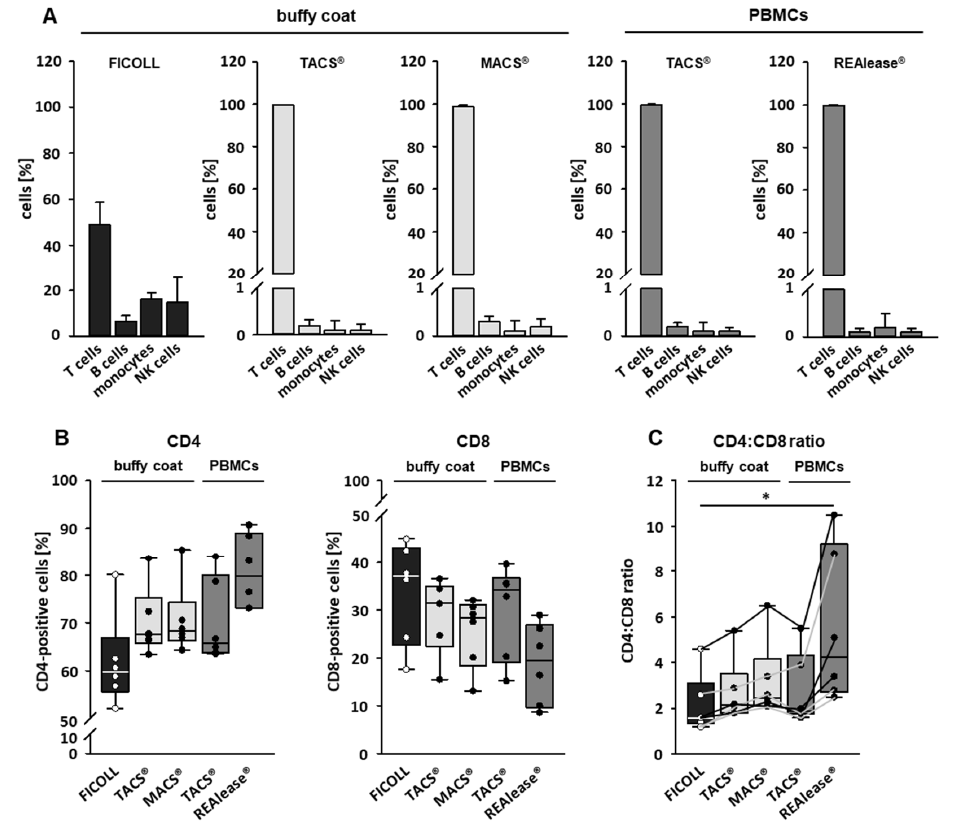
Figure 3. Purity of separated CD3-positive cells. The purity of the cells after isolation was determined by flow cytometry. CD3-positive cells were either separated from buffy coats by the MACS ® and TACS ® system or from Ficoll purified PBMCs by the TACS ® and REAlease ® system. Data show the percentage of isolated cells ± SD, n = 6 ( A ). CD4-positive and CD8-positive cells within the CD3-positive cell population were determined by flow cytometry ( B ) and the CD4:CD8 ratio was calculated ( C ). The lines in ( C ) connect data derived from the individual donors, n = 6. Box plots indicate median (horizontal lines), interquartile range (box), and range (whiskers). Mann Whitney Rank Sum Test, * = p ≤ 0.05.